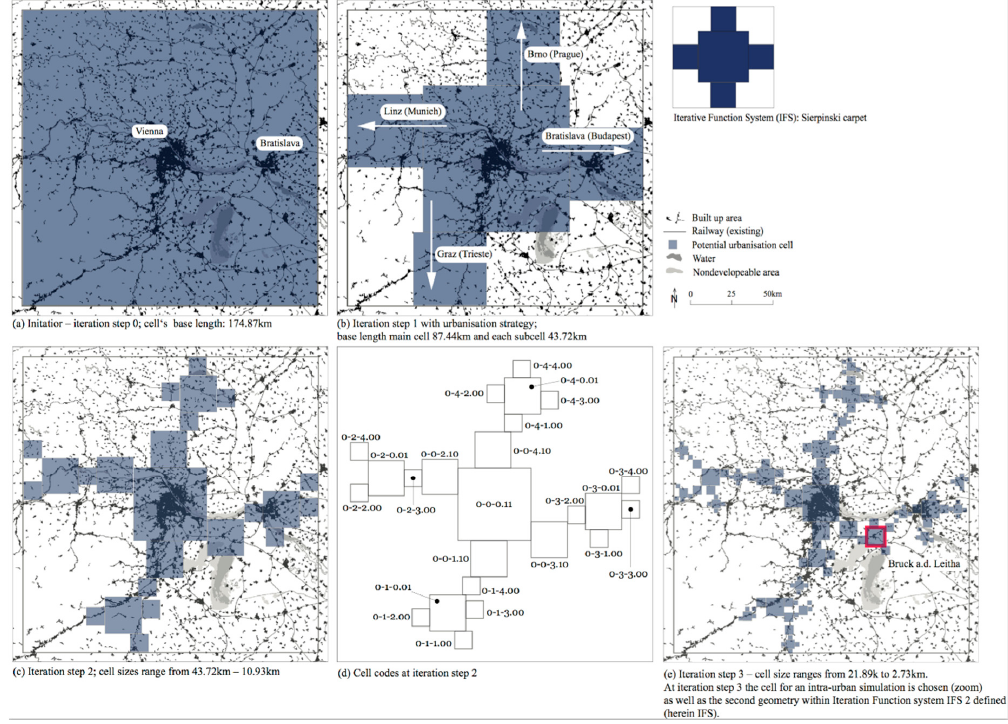
Figure 5. Designing a strategic development plan: iteration steps 0–3. For illustrative purposes, we have deactivated the street network layer.